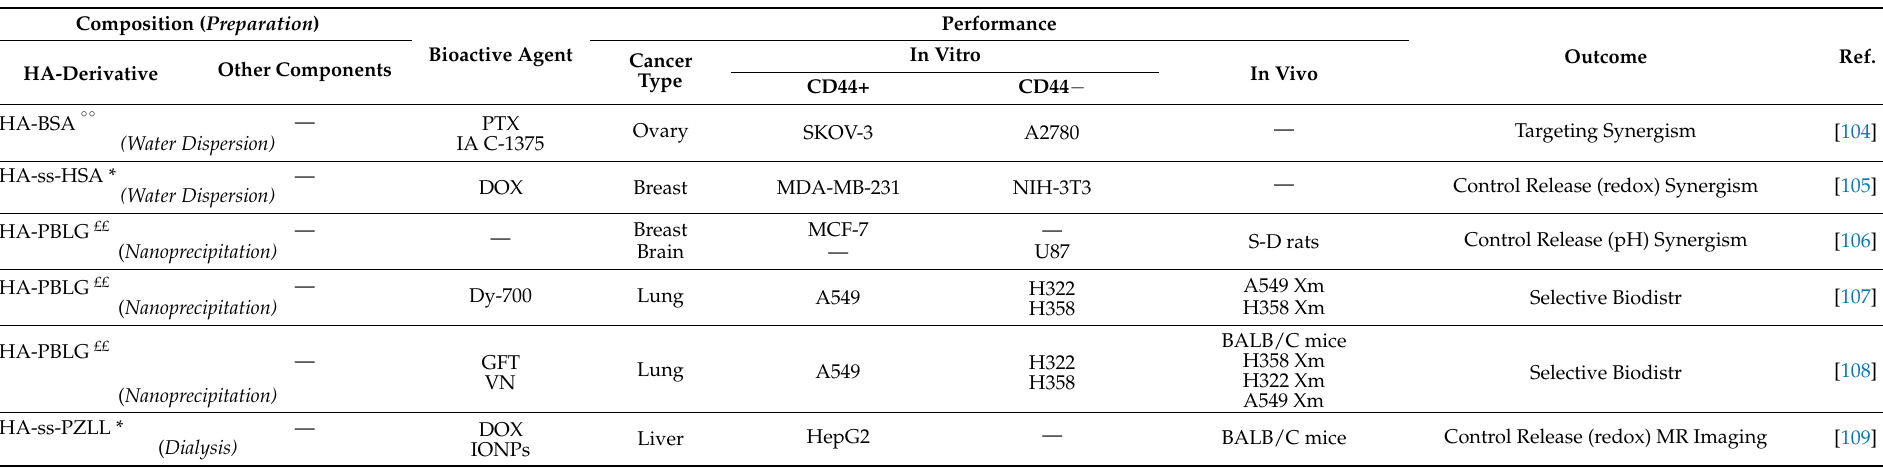
Table 5. HA-SANPs obtained by HA modification with polymeric